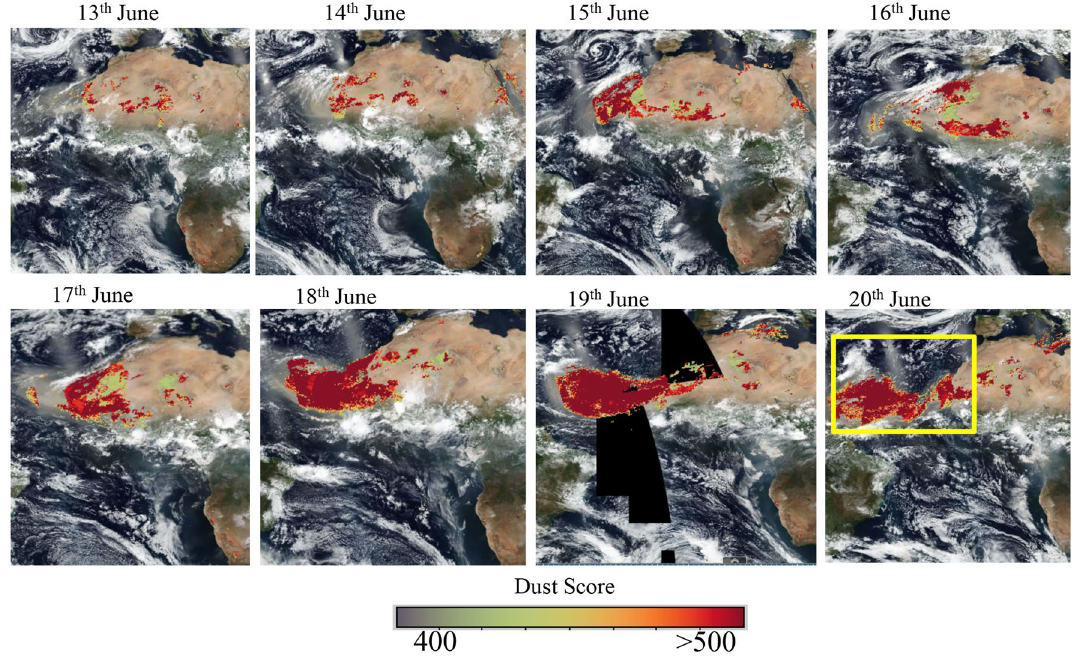
Figure 1. MODIS visible imagery indicating the evolution and transport of dust storm over the tropical Atlantic Ocean. The light brown colour indicates dust and the white shows clouds. The colour bar shows the value of the dust score from AIRS Level 2 datasets. The yellow box indicates the region of interest used for further analysis. These open-source datasets can be found in (https:// earth data. nasa. gov/). The map was generated using MATLAB 2015b, www. mathw orks.